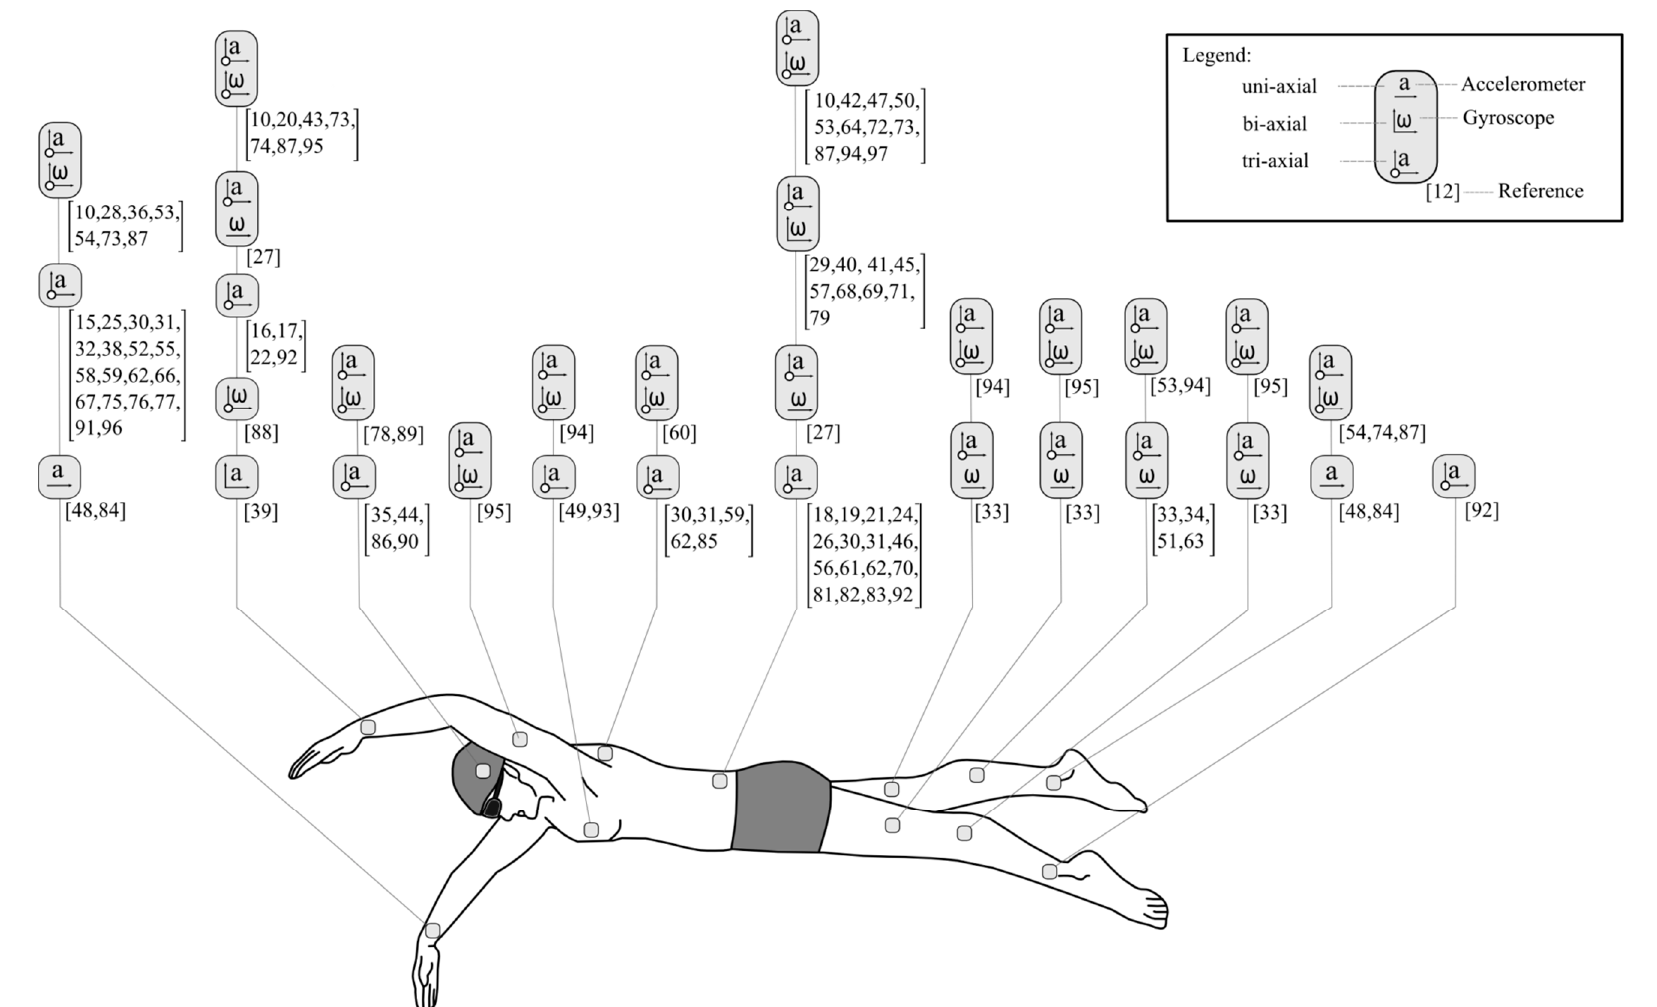
Figure 4. Locations and specifications of different inertial sensor units used in previous swimming related studies. Studies have used devices in both single and multiple sensor configurations. The most popular locations are the lower back and wrist/lower arm and the most prevalent sensor specifications incorporate a tri-axial accelerometer and tri-axial gyroscope.